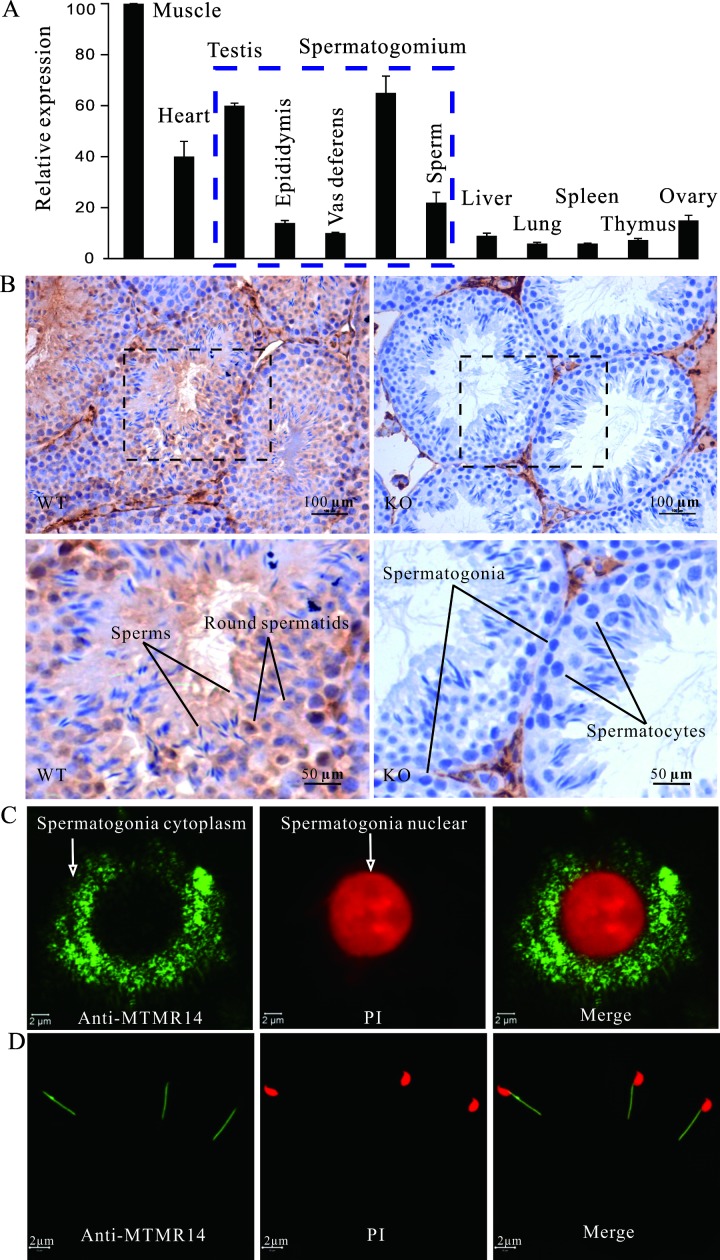
MTMR14 was expressed in mouse testes, spermatogonia, and mature sperm.(A) Real-time PCR analysis of mRNA expression profiles of MTMR14 in mice. The tissues of mouse skeletal muscle, heart, testis, epididymis, vas deferens, spermatogonium, sperm, liver, lung, spleen, thymus, and ovary were harvested. Then, their total mRNA levels were prepared, reverse transcribed, and analysed by real-time PCR. Beta-actin was used as a control. (B) Immunohistochemical localization of MTMR14 in mouse testes. Testis sections were obtained from KO/WT male mice, incubated with primary anti-MTMR14 antibody, and counterstained with haematoxylin and eosin. The scale bar was 100 μm. The sections from KO mice testes were used as negative controls and did not show any labelling. (C) Immunofluorescence detection of MTMR14 in spermatogonia; single spermatogenic cells were isolated from WT mice and incubated with primary anti-MTMR14 antibody and FITC-conjugated secondary antibody. After counter-staining with PI, the fluorescence signal was detected using a confocal microscope. The scale bar was 2 μm. Separate replicate experiments in both WT and MTMR14 mice were performed at least three times. (D) Immunofluorescent detects of MTMR14 in mature mouse sperm. Mature sperm were isolated from mouse vas deferens and stained as described above. These data demonstrated that MTMR14 was expressed in mouse testis, spermatogonium, and mature sperm, suggesting that MTMR14 plays a role in male fertility.